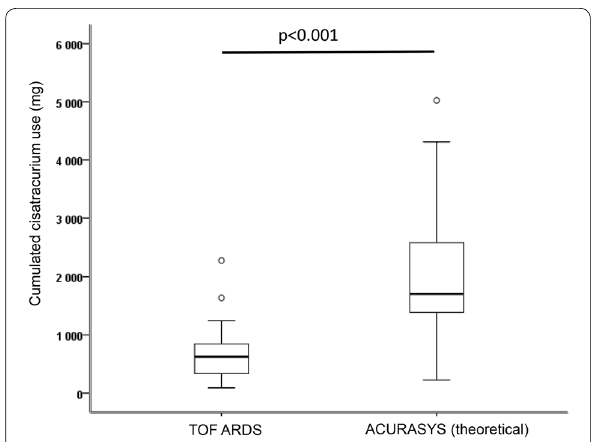
Fig. 3 Cumulative cisatracurium doses received by the study patients compared to the theoretical dosage that would have been administered according to the ACURASYS study. The box plot limits represent the 25th and 75th percentiles, and the bars represent the 5th and 95th percentiles. The median is represented as a horizontal line. Extreme values are represented by